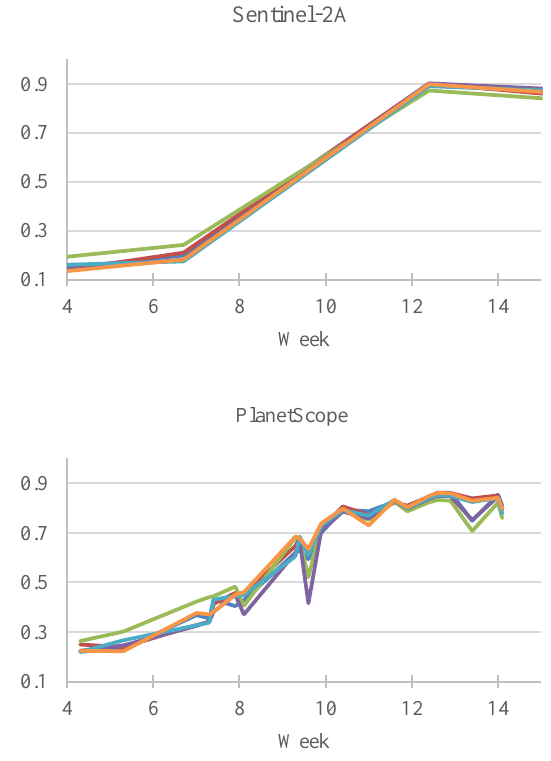
Figure 5. Variation of NDVI over the 2017 growing season Sentinel-2A vs. PlanetScope for Idaho fields